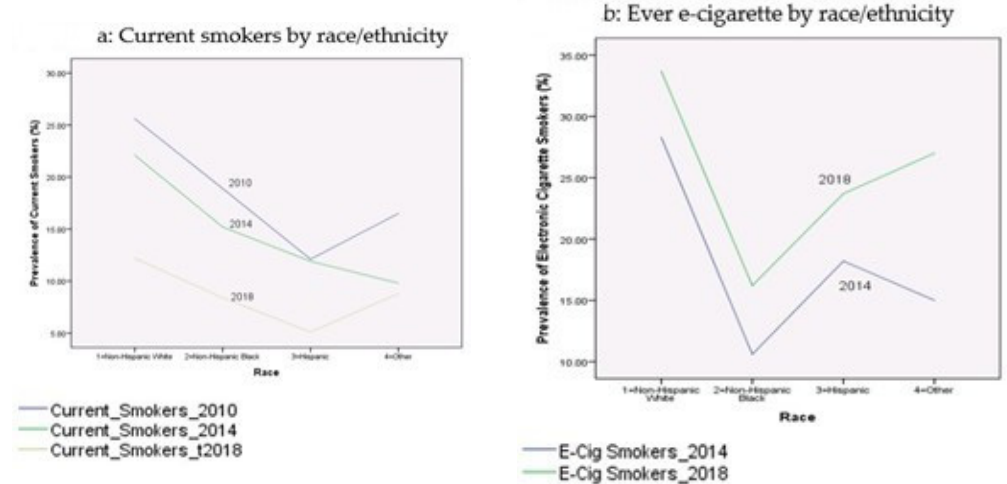
Figure 2. Prevalence of smoking behaviors by race / ethnicity, NHIS 2010–2018.